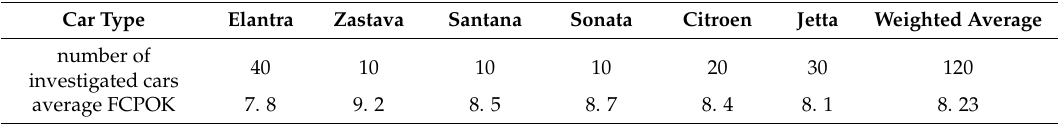
Figure 10. Average fuel consumption throughout one day. Table 4. Investigated fuel consumption per 100-km (FCPOK) results (L/100 km).